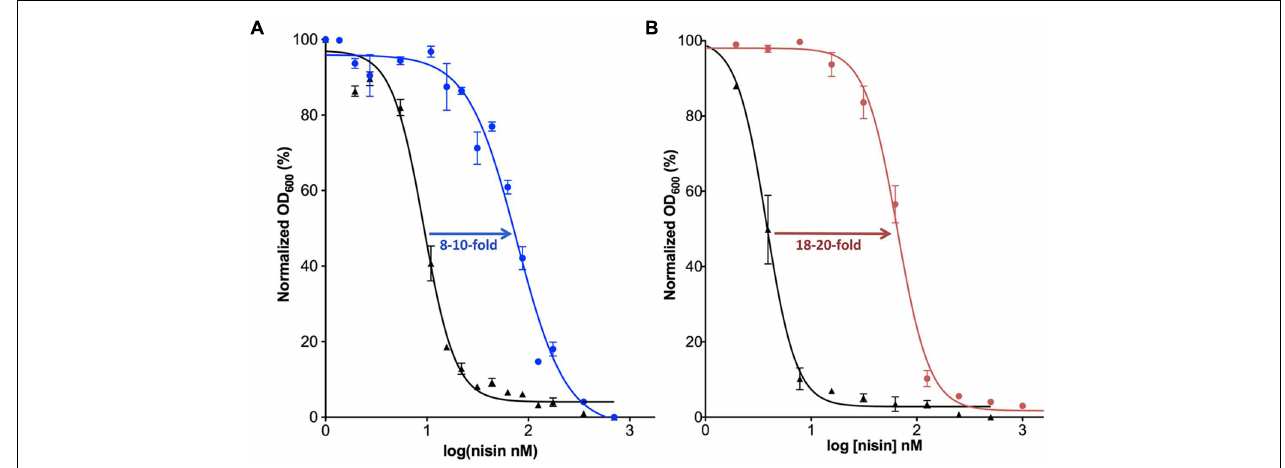
FIGURE 2 | Activity determination of NisI and Sa NSR. The IC 50 value was determined for the nisin sensitive Lactococcus lactis NZ9000 strain (black) in comparison with the same strain harboring a plasmid containing the nisI ( A ; shown in blue) or nsr ( B ; shown in pink)